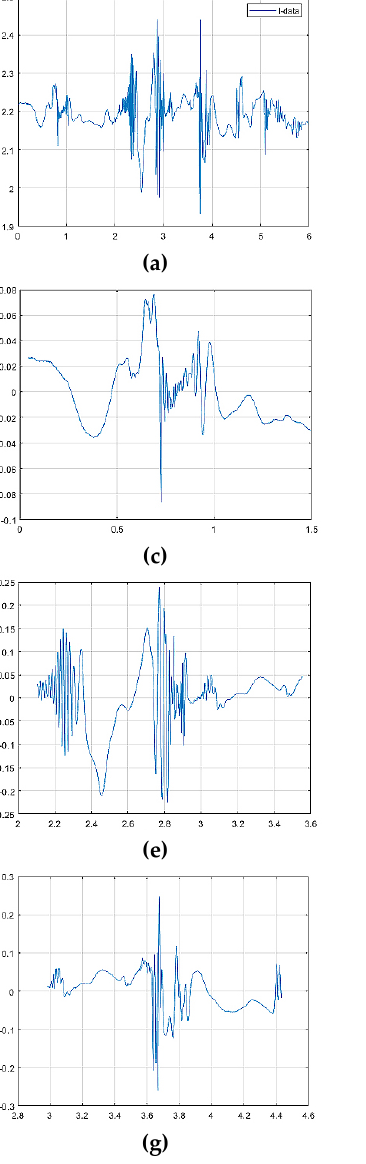
Figure 14. Detection probability of multiple hand gestures: ( a ) I-data of raw data; (b ) Q-data of raw data; ( c ) I-data of the first hand gesture; ( d ) Q-data of the first hand gesture; ( e ) I-data of the second hand gesture; ( f ) Q-data of the second hand gesture; ( g ) I-data of the third hand gesture; ( h ) I-data of the third hand gesture.